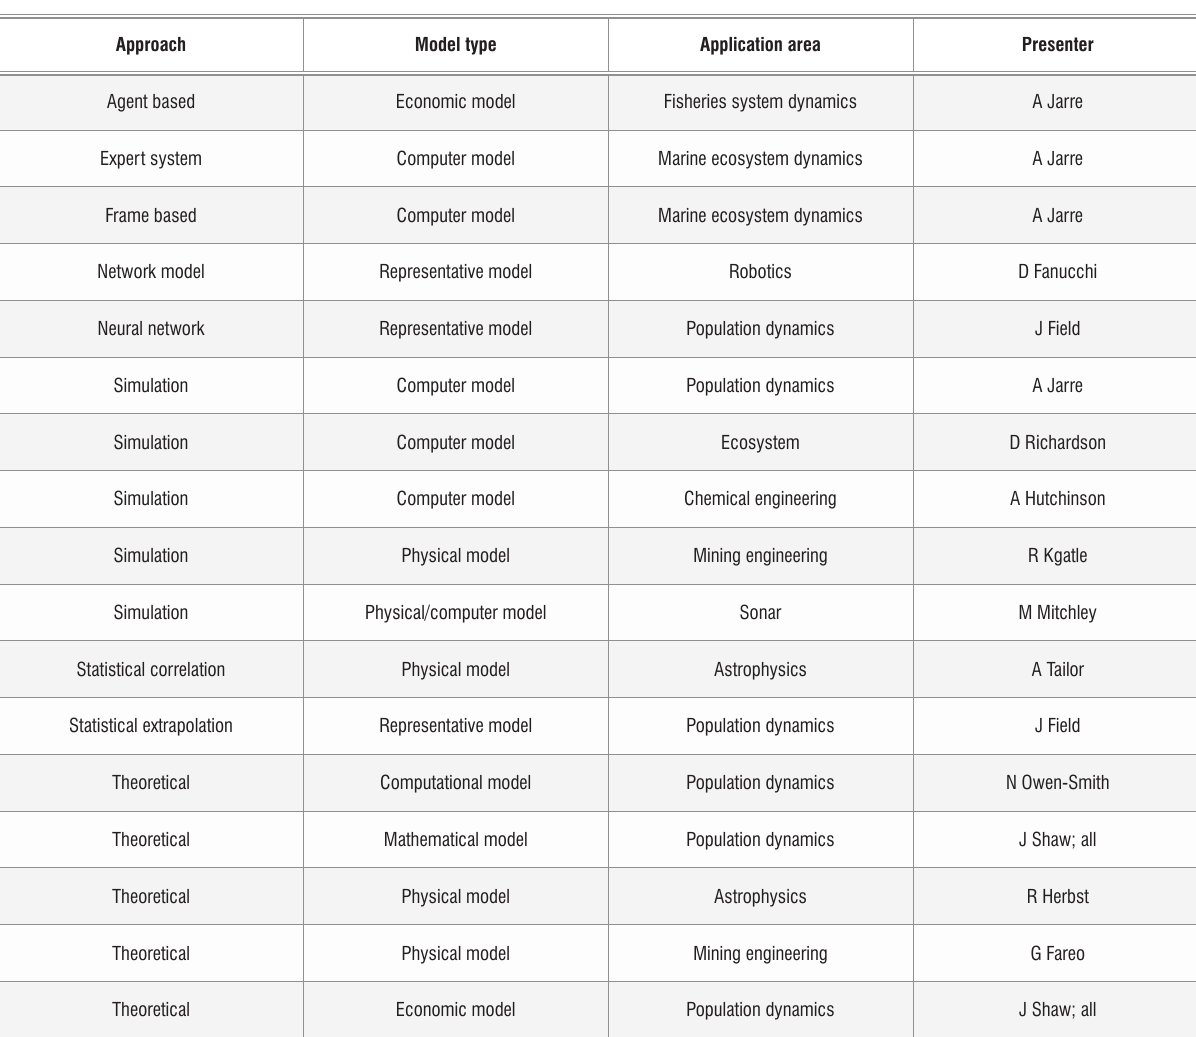
Classification of presentations at the